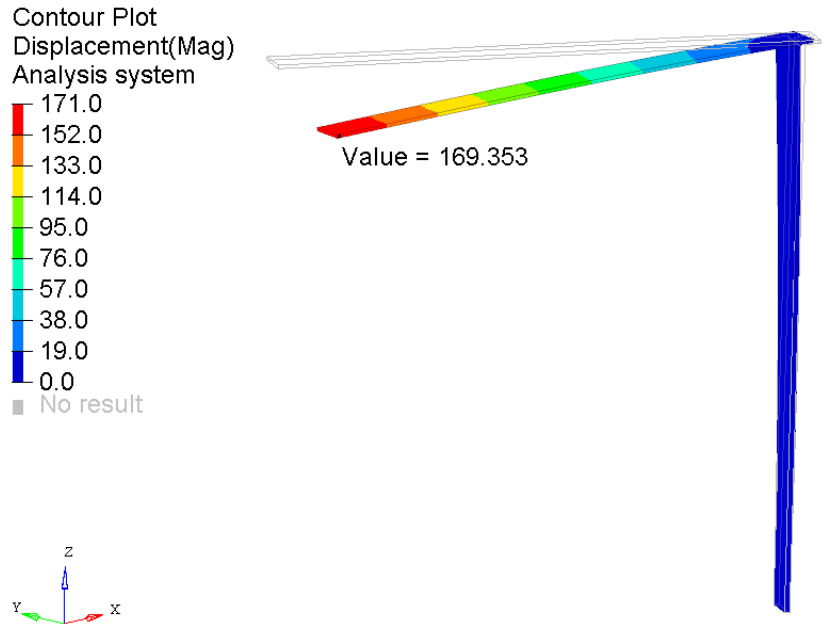
Figure 7. Results of the displacement of the tower crane structure subjected to complex load.